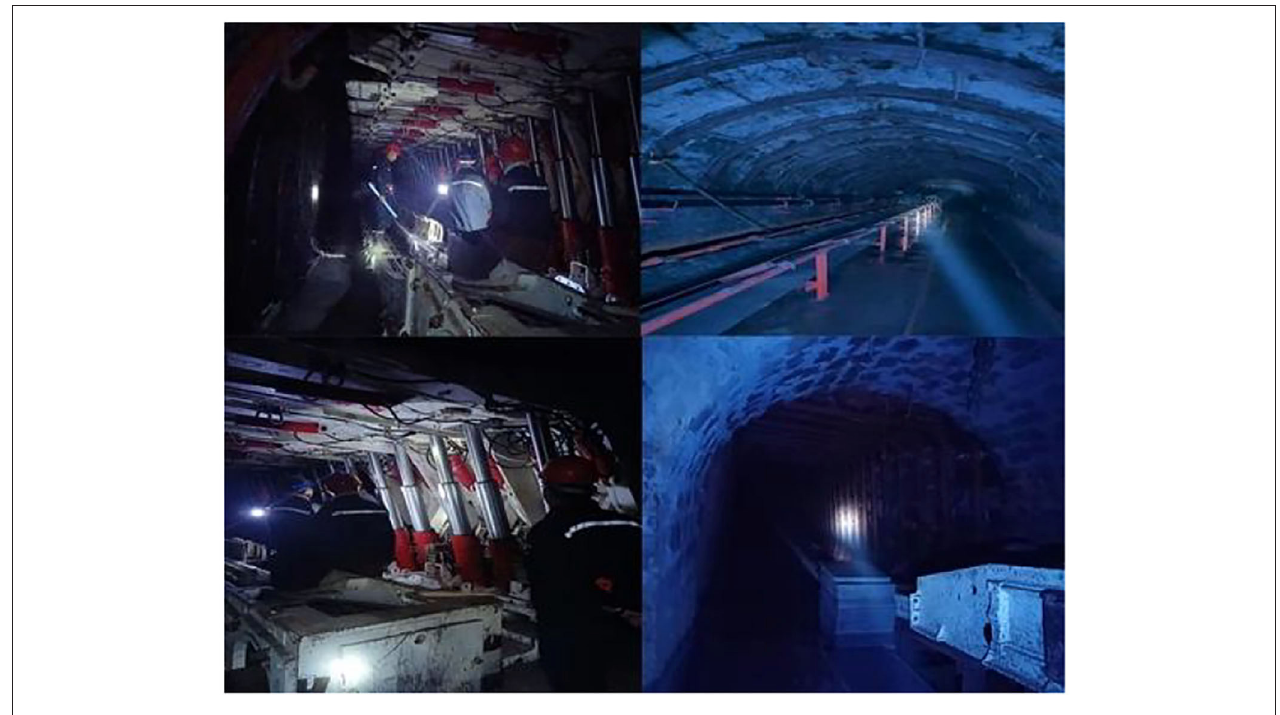
FIGURE 4 | Current situation of underground coal mine.